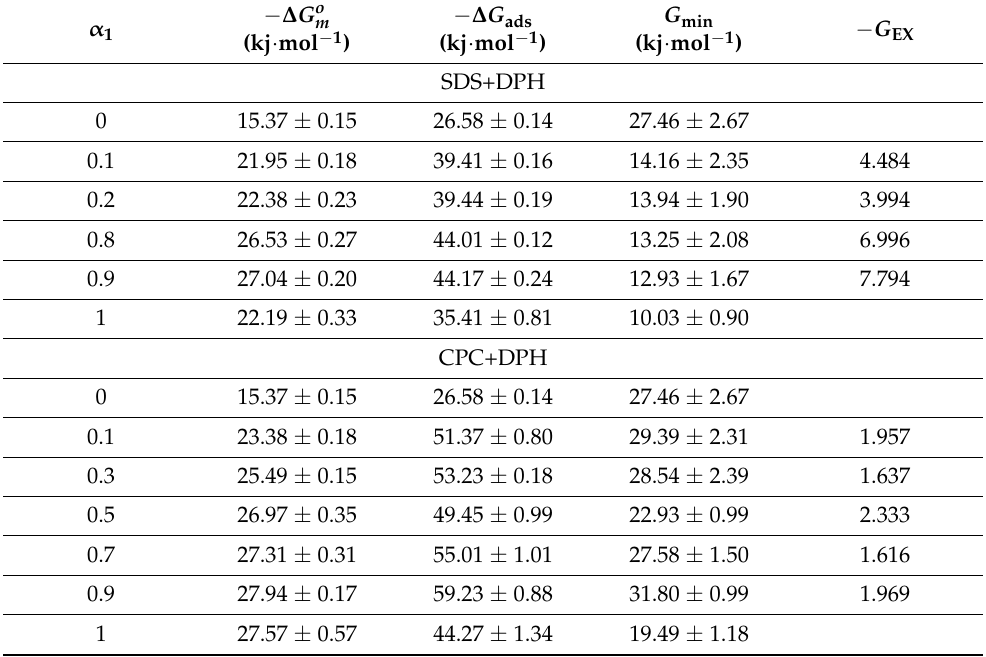
Table 4. Thermodynamic parameters of DPH and SDS/CPC mixed at temperature T = 298.15 K. Values are the mean ± SD ( n =